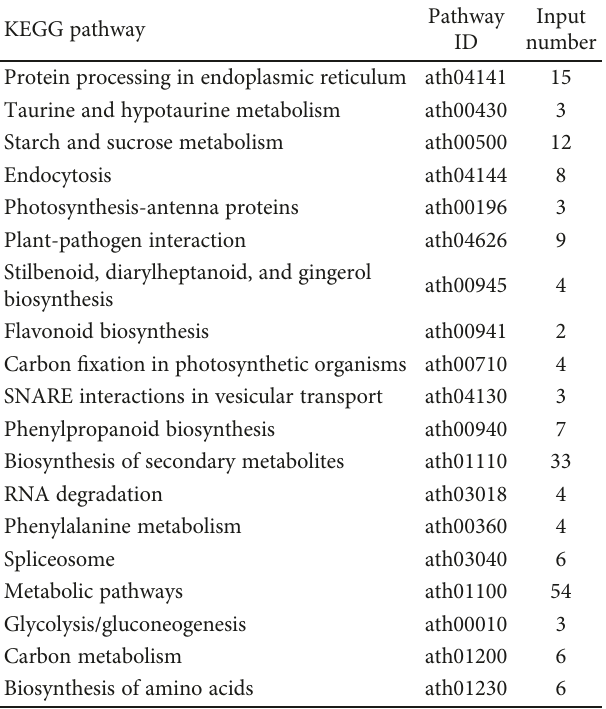
Table 4: KEGG analysis of common di ff erentially expressed